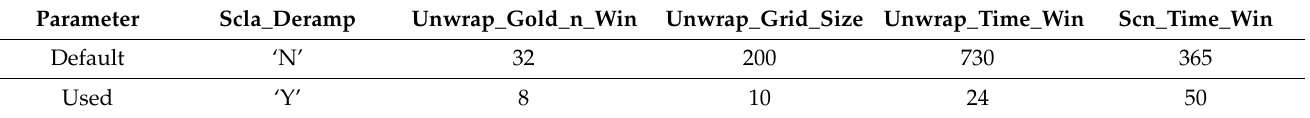
Figure 3. Distribution of the temporal and perpendicular baselines of Sentinel-1 SAR data used for PSInSAR. The red dots indicate the master data from 19 October 2019 for the ascending orbit and from 5 January 2020 for the descending orbit. Table 2. Parameters Used in the StaMPS